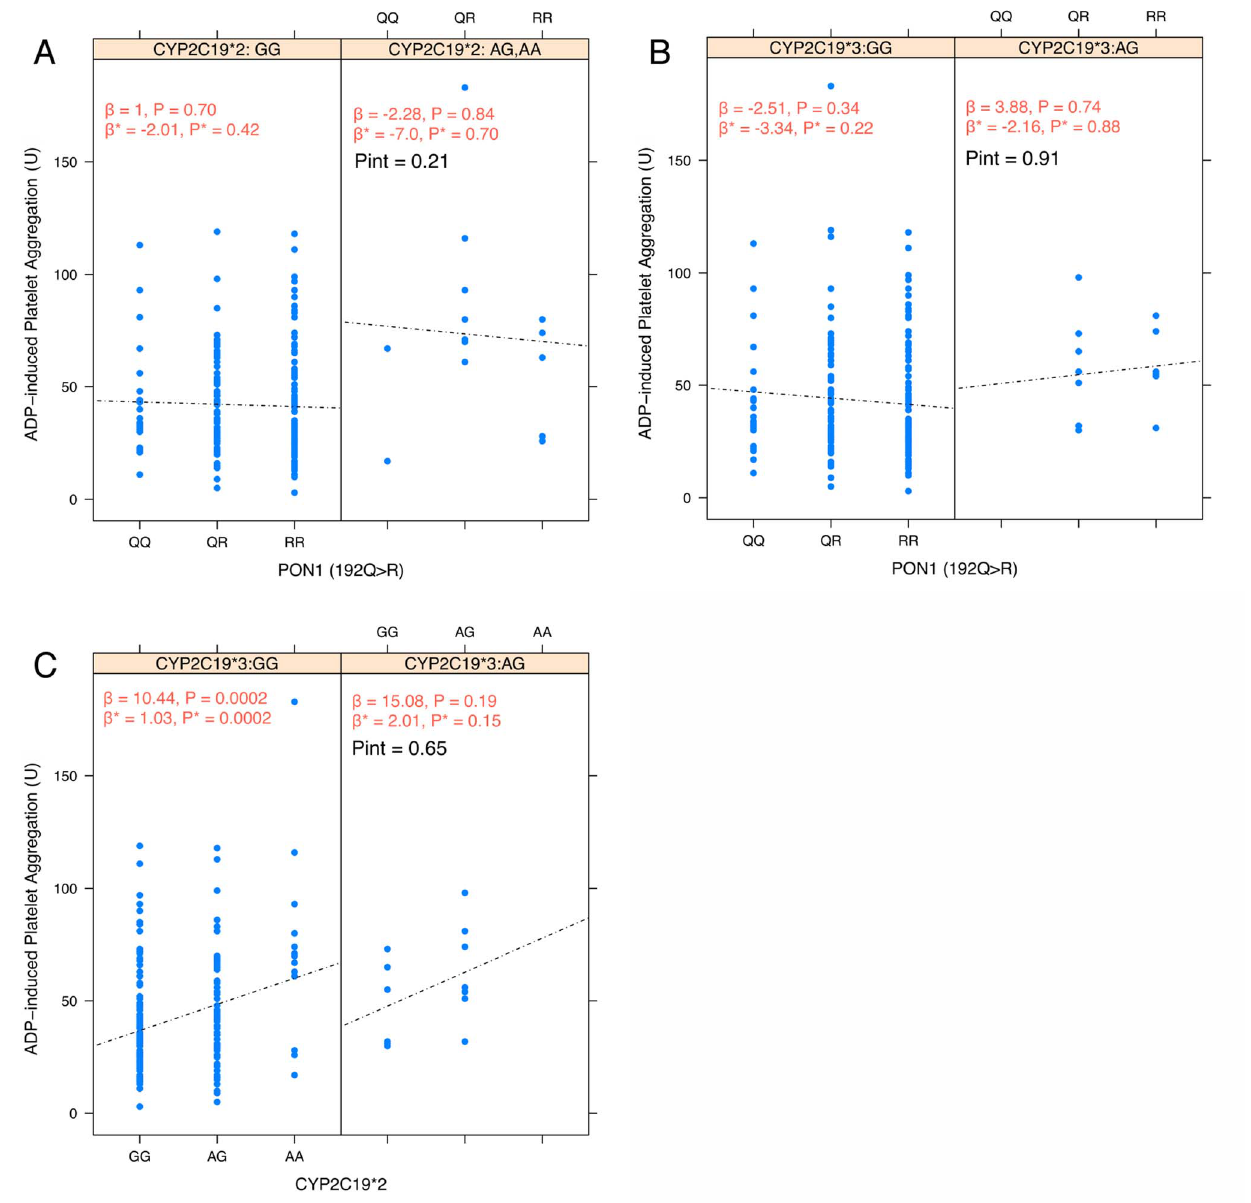
Figure 1. Interaction among polymorphisms in CYP2C19*2, *3 and PON1 Q192R and the effects on ADP-induced platelet aggregation. A) Effects of PON1 Q192R polymorphism on platelet aggregation stratified by CYP2C19*2 genotype; B) Effects of PON1 Q192R polymorphism on platelet aggregation stratified by CYP2C19*3 genotype; C) Effects of CYP2C19*2 on platelet aggregation stratified by CYP2C19*3 genotype doi:10.1371/journal.pone.0110188.g001 Table 6. Standardized linkage disequilibrium coefficient (D 9 ) and correlation coefficient (r) among three polymorphisms in CYP2C19 and PON1.